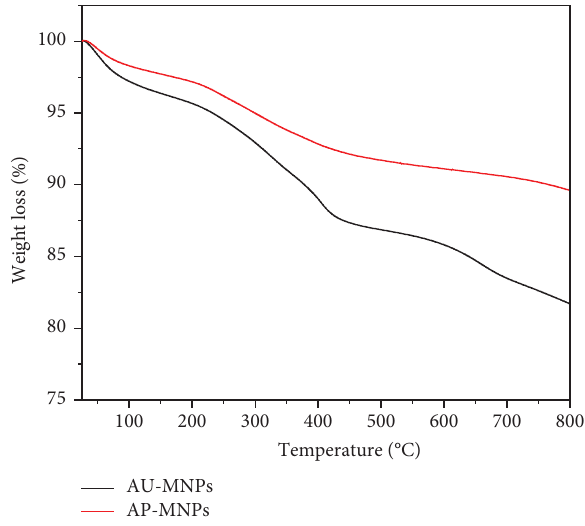
Figure 4: TGA of AU-MNPs and